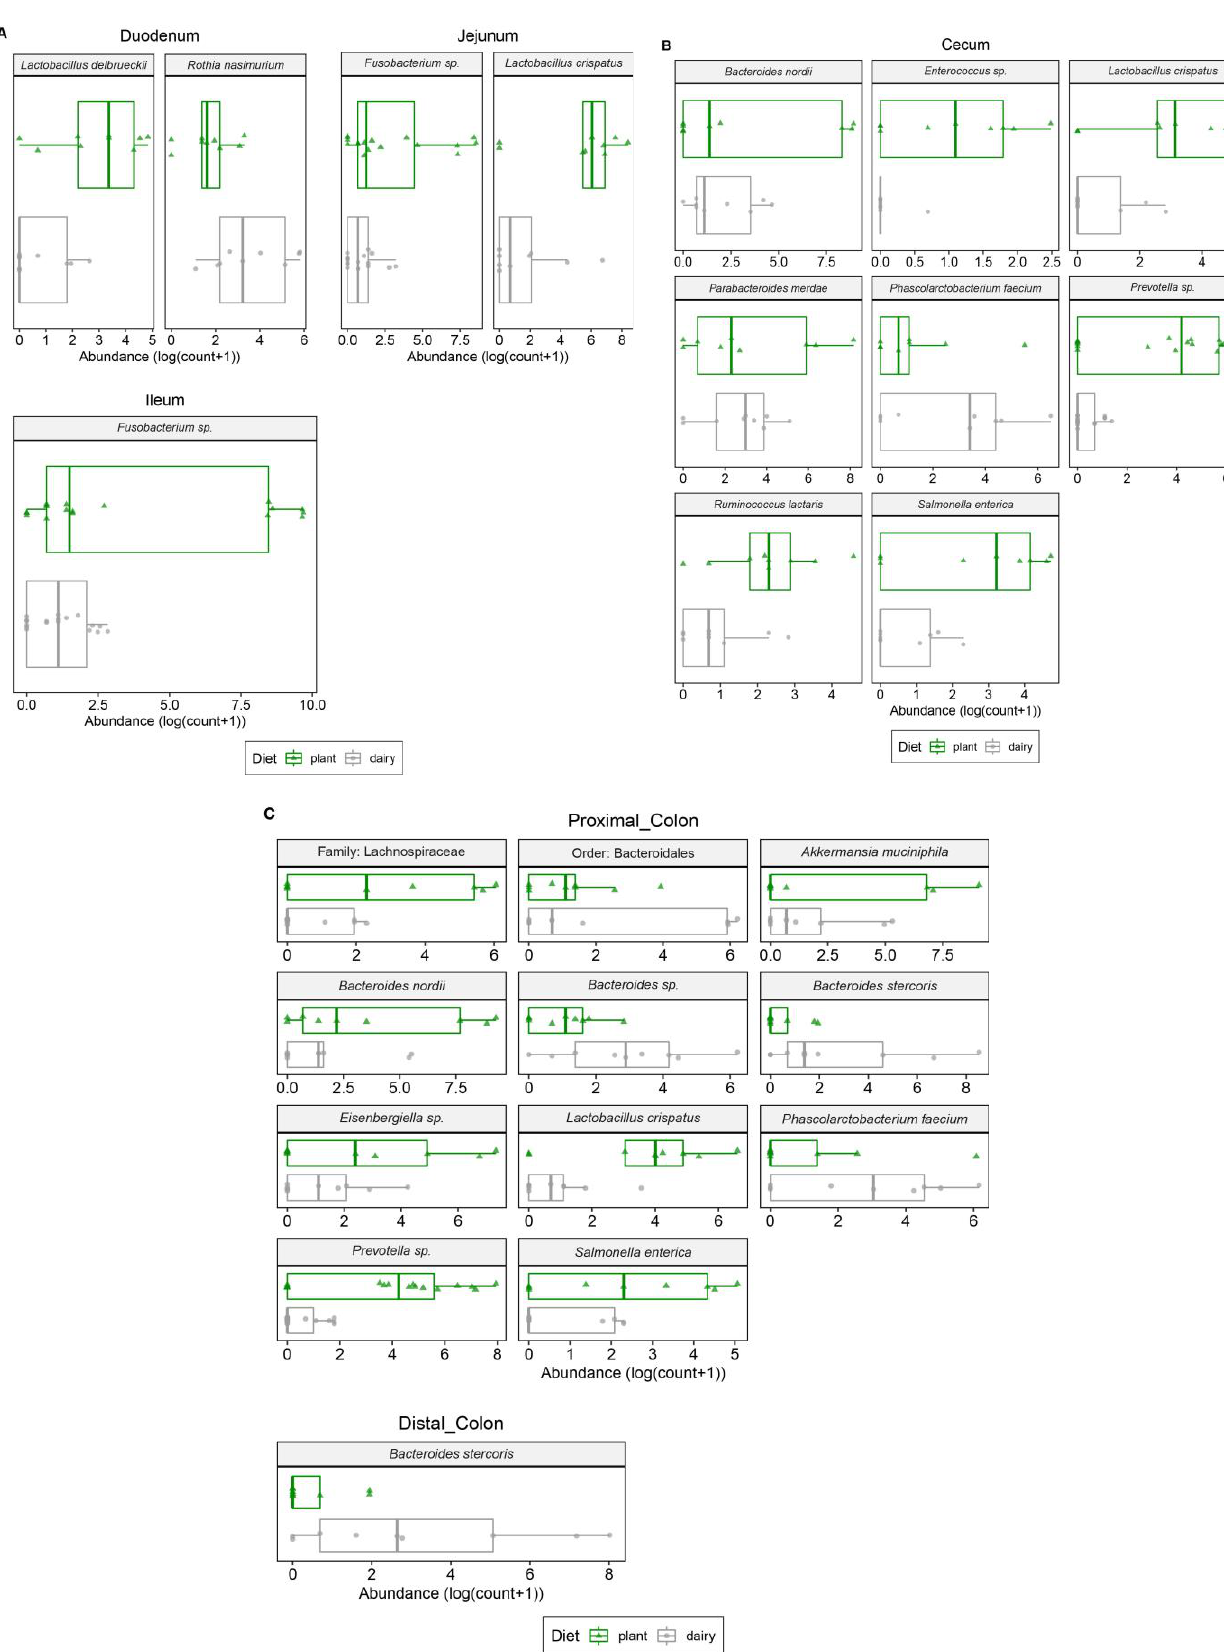
Figure 4. Differentially abundant bacteria in the intestinal contents from 21-day old piglets fed either a plant- or a dairy-based formula ( n = 9 per group). Only the significantly abundant taxa are shown.